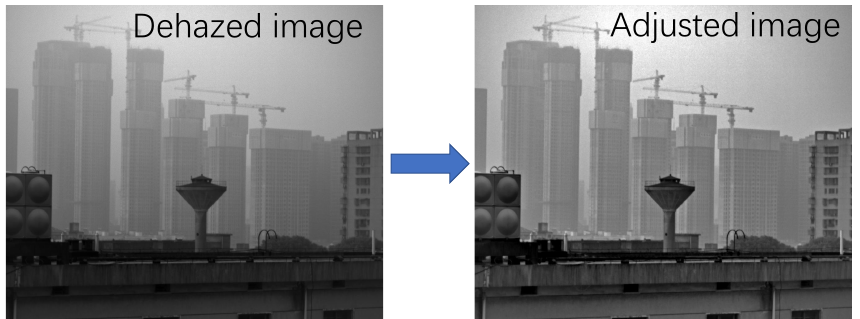
Figure 3. The comparison between dehazed image and adjusted